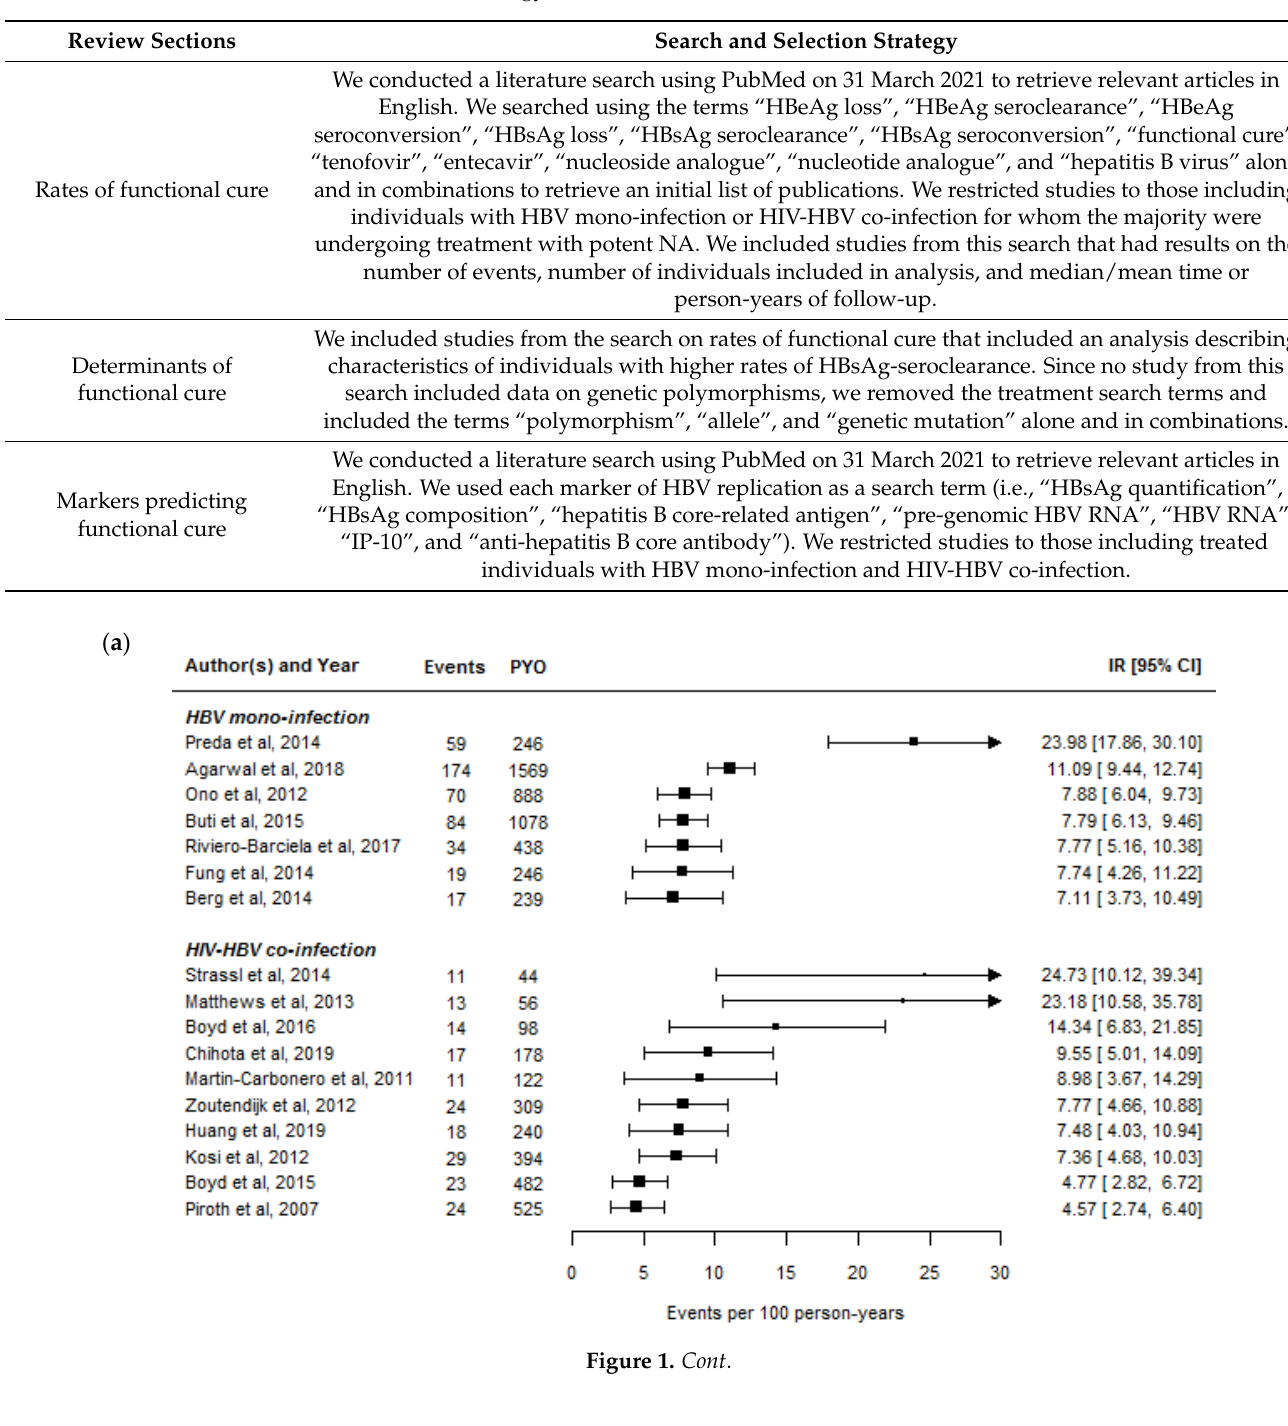
Table 1. Search strategy and selection criteria for this literature review.